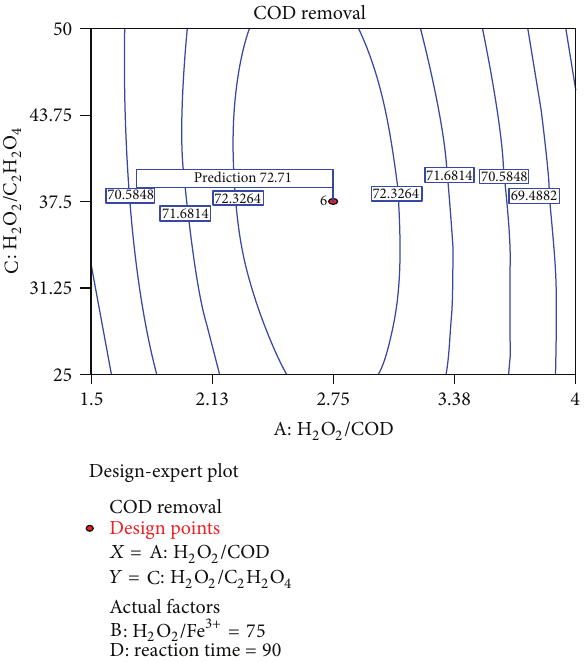
Figure 2: Contour plot for COD removal.